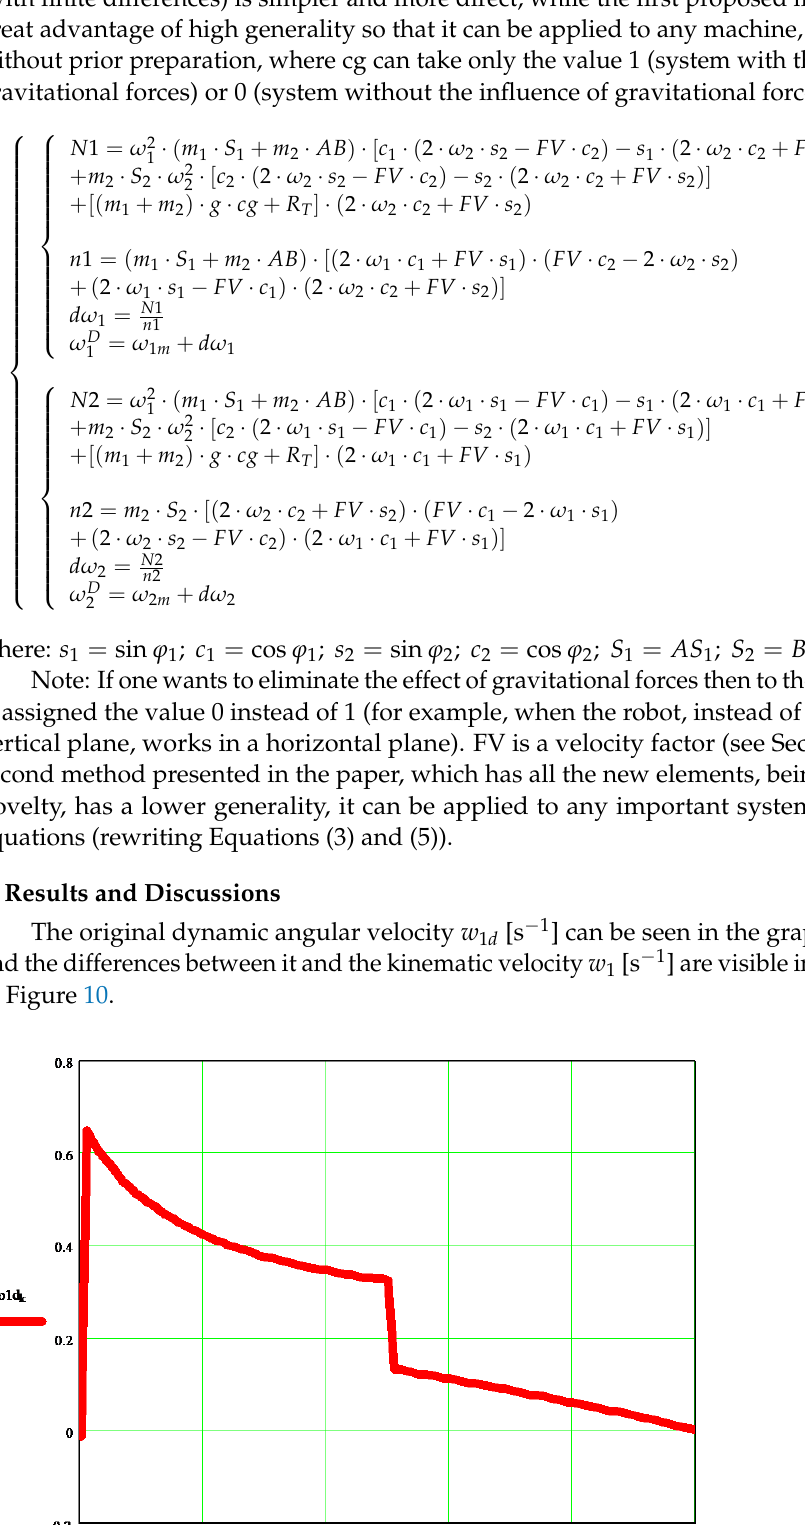
Figure 10. The differences between angular dynamic velocity w 1 d and the angular kinematic velocity w 1. The original dynamic angular velocity w 2d [s − 1 ] can be seen in the graph in Figure 11, and the differences between it and the kinematic velocity w 2 [s − 1 ] are visible in the dia- grams in Figure 12. Figure 11. The original dynamic angular velocity w 2d.